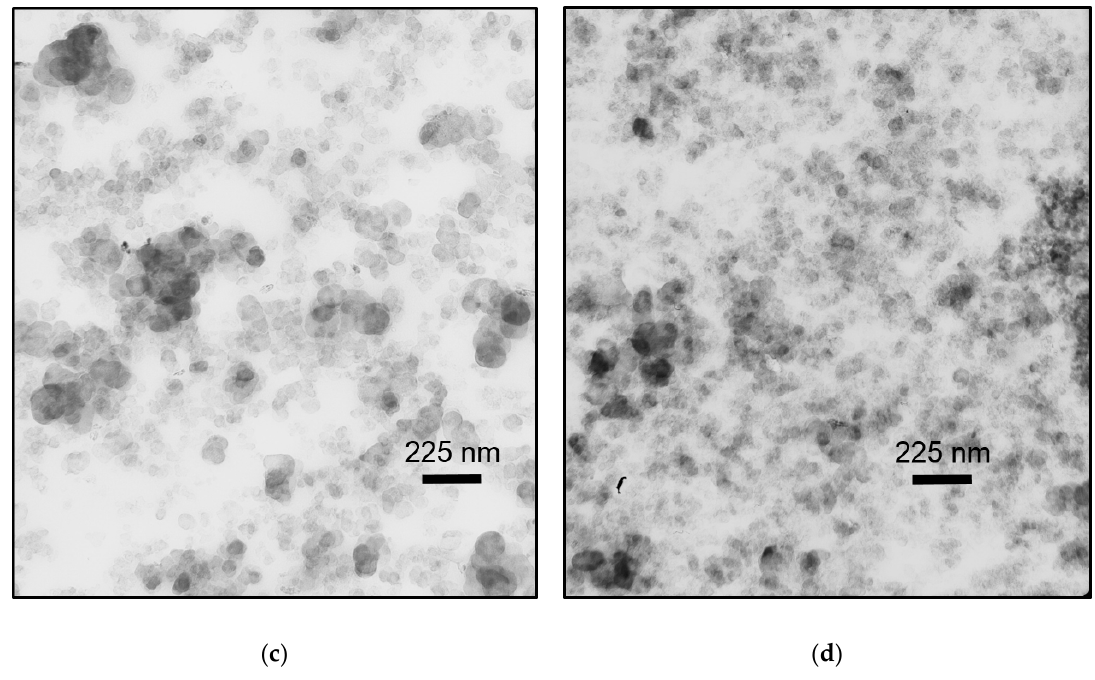
Figure 2. TEM micrographs of HNBR filled with different CB grades: ( a ) HNBR1; ( b ) HNBR2; ( c ) HNBR3; ( d ) HNBR4.